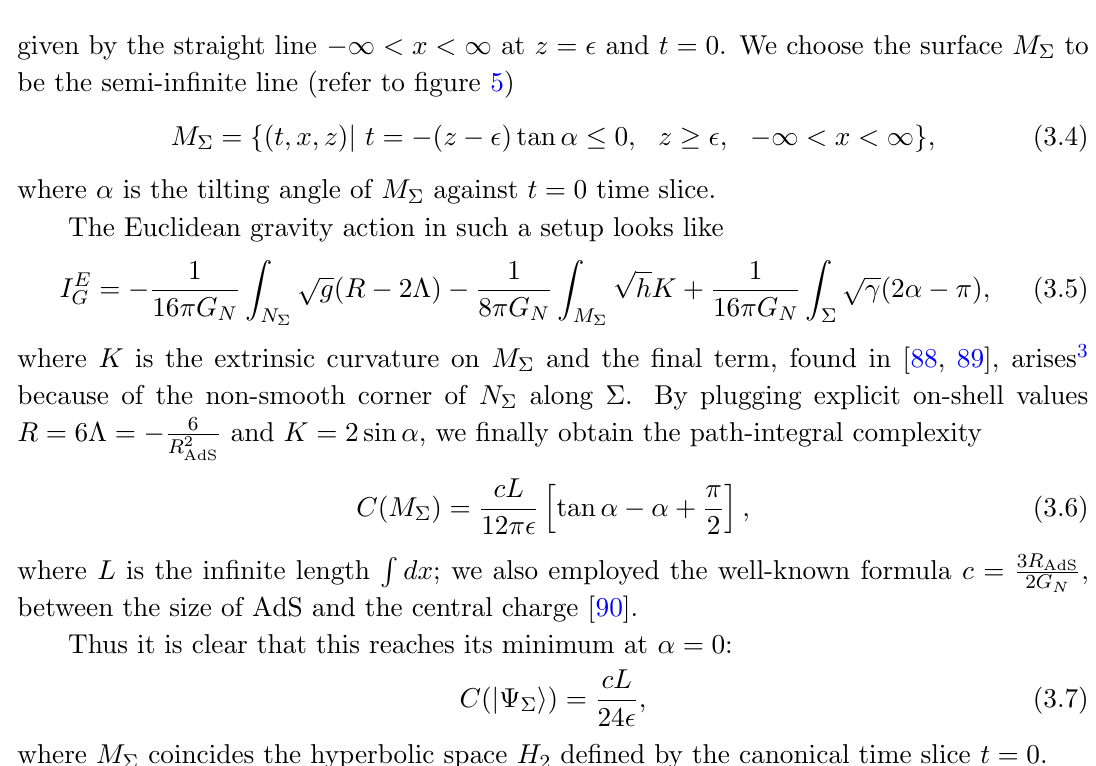
Figure 4 . The sketch of holographic computation of path-integral complexity in a global Euclidean AdS. For simplicity, we choose (cid:6) is a codimension two convex surface on a time slice t = 0. Originally, the state j (cid:9) (cid:6) i dual to the surface (cid:6) is obtained by the path-integration along the Euclidean time with a coarse-grained CFT action as in the left picture. Then we can deform the space M (cid:6) on which we perform the path-integration without changing the quantum state j (cid:9) (cid:6) i as depicted in the middle picture. The bulk region surrounded by the time slice t = 0 and M (cid:6) is called N (cid:6) . During this process we can reduce the normalization of wave function and this normalization is computed by doubling the system namely the inner product h (cid:9) (cid:6) j (cid:9) (cid:6) i . In the gravity dual, this inner product is given by the gravity action evaluated on the Euclidean space given by a double copy of N (cid:6) , depicted in the right